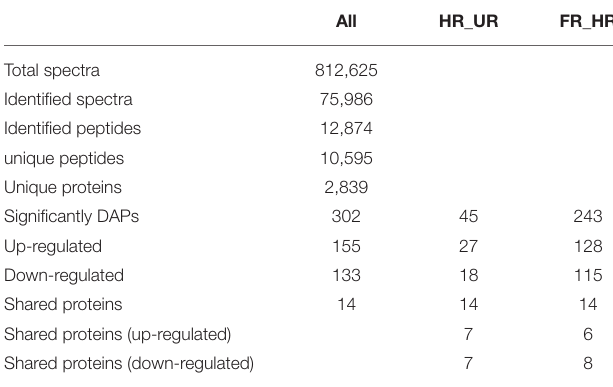
TABLE 1 | Summary of proteins detected from TMT sequence